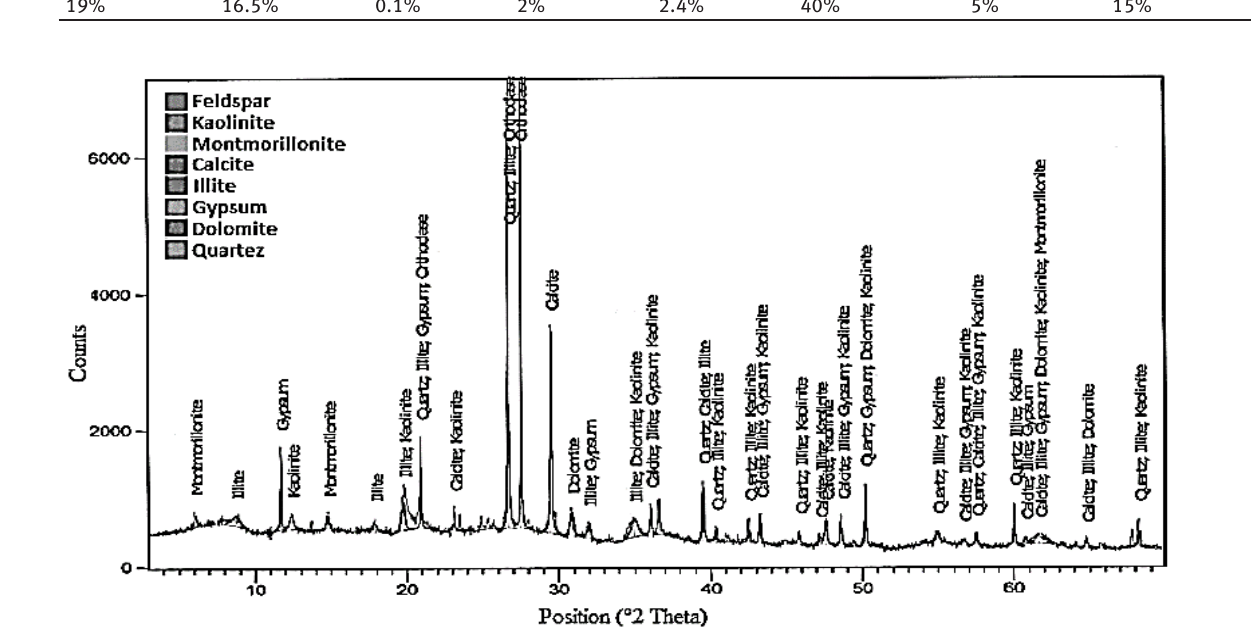
Figure 2: X-ray diffraction of the studied material (Boumagueur